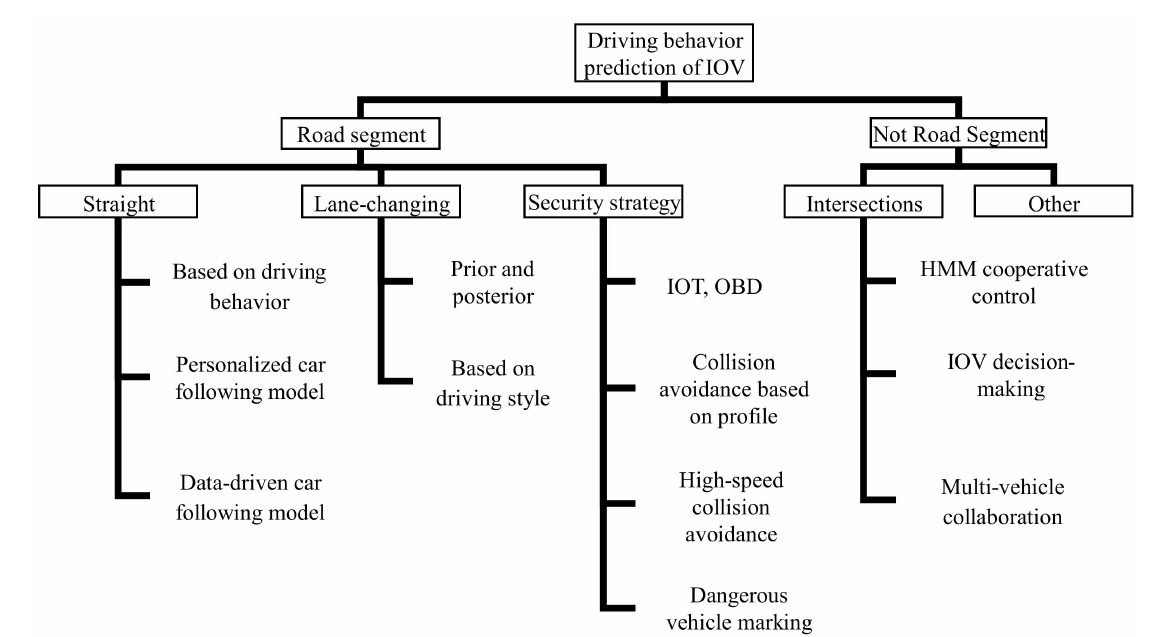
Figure 3. Structure chart of IoV driving behavior